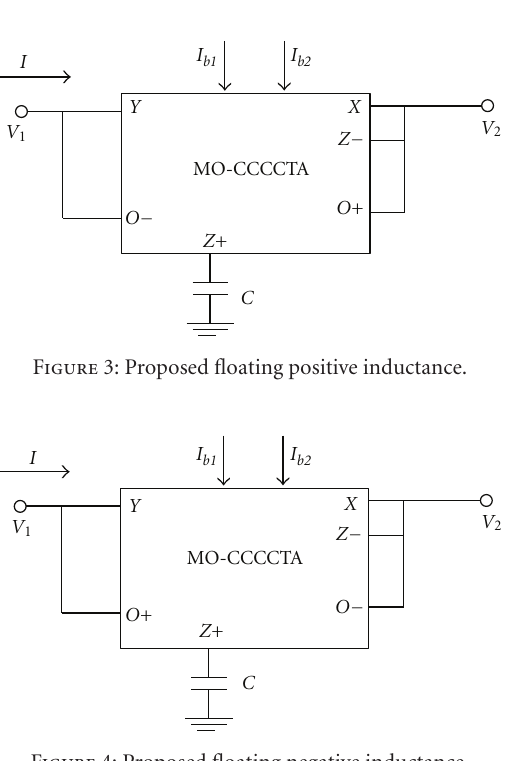
Figure 4: Proposed floating negative inductance.